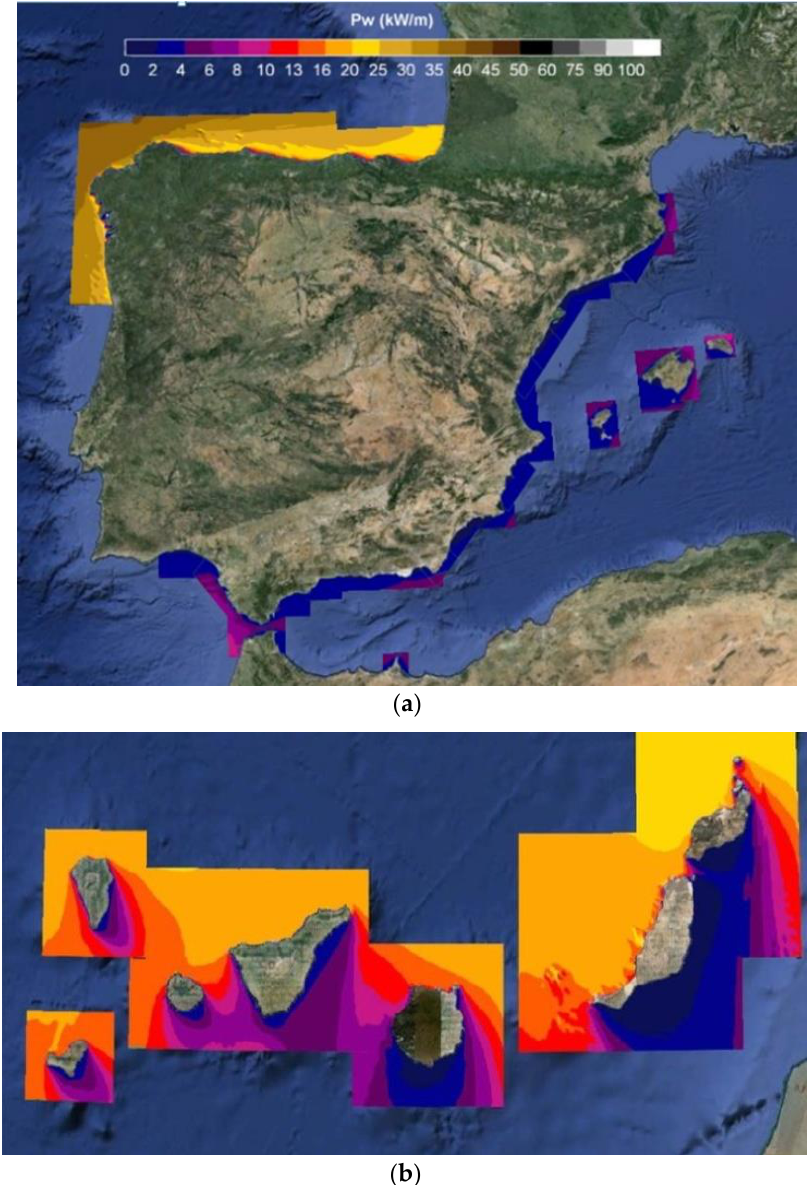
Figure 12. Annual average wave power, in kW / m: ( a ) in the Iberian Peninsula and ( b ) Canary Island coast (Reproduced with permission from [72]. IHCantabria, 2019).